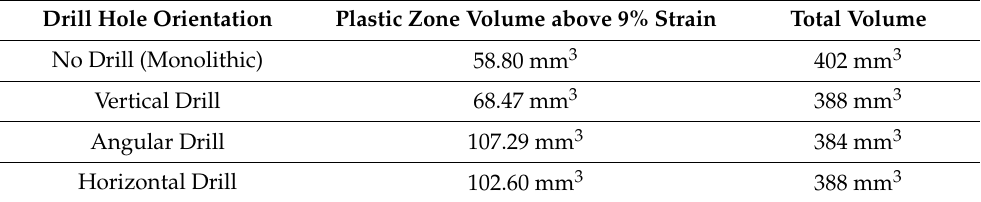
Table 1. Plastic zone volume above 9% strain observed at various drill hole orientations.